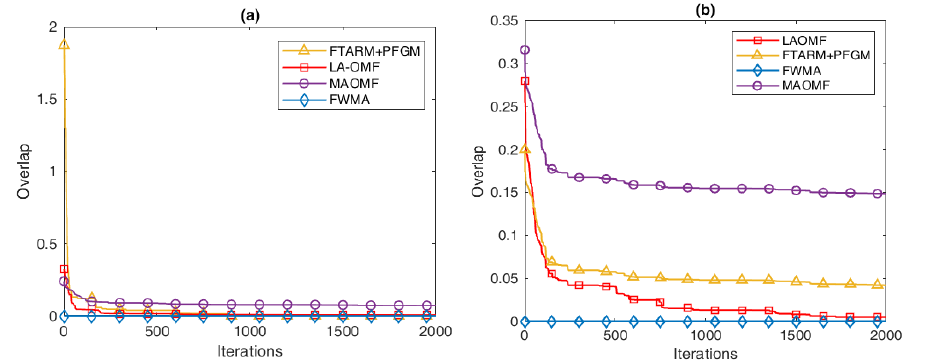
Figure 15. Change of overlap along with different numbers of iterations for four test algorithms on different datasets. (a) 50k sessions and (b) 250k sessions.